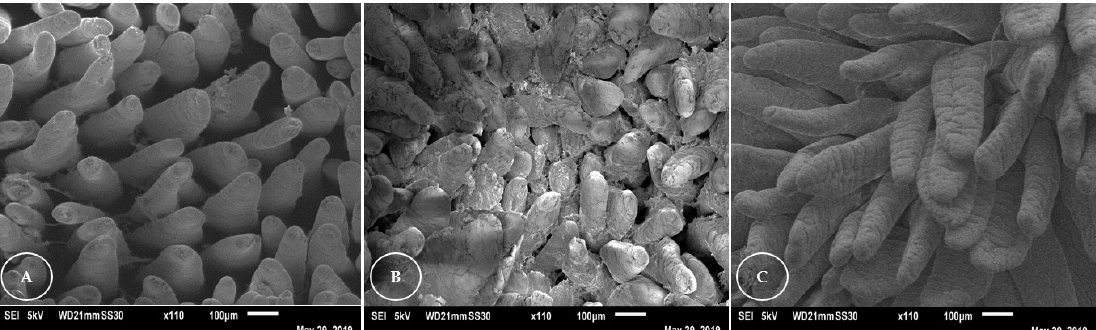
Figure 3. Ultrastructural analysis of the jejunum of rabbits that were fed three experimental diets: ( A ) Control, ( B ) Nanosoy, and ( C ) Nanopupunha.